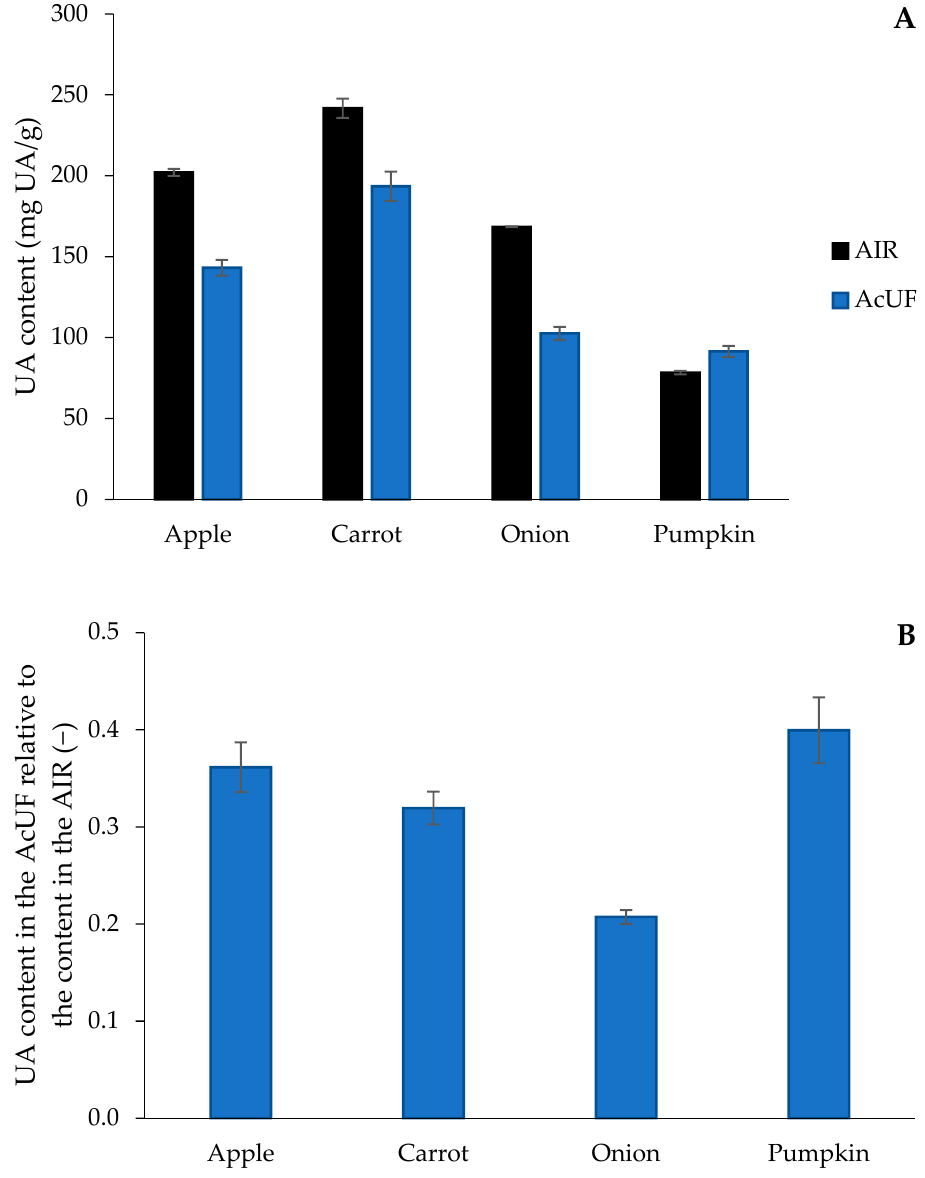
Figure 1. Uronic acid (UA) content in the alcohol-insoluble residues (AIR) ( n = 2) and the acid-unextractable fractions (AcUF) ( n = 2 × 2) of the different matrices ( A ) and the UA content in the AcUF expressed relatively to the content in the AIR ( B ). The error bars represent the standard deviation.